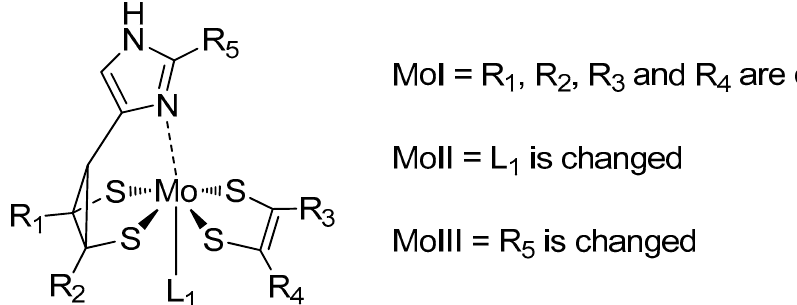
Figure 6. Some Mo ‐ dithiolene complexes potentially interesting for CO 2 reduction according to the DFT calculations.